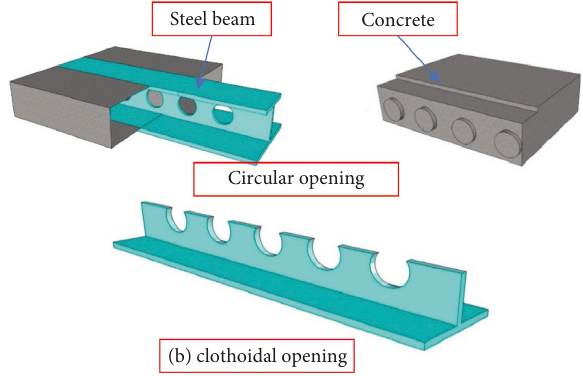
Figure 11: Web opening shear connectors for slim/shallow floor steel